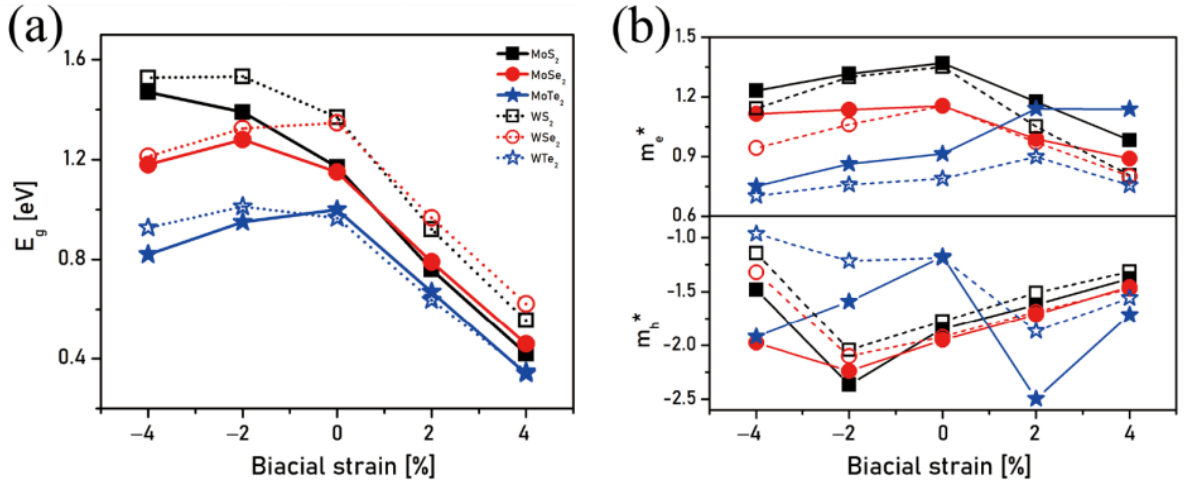
Figure 3. ( a ) Bandgap energies and ( b ) electron and hole effective masses (m e * and m h *, respectively) at the respective CBMs and VBMs with respect to applied strains from −4% to +4% for the MX 2 bilayer structures (M = Mo, W; X = S, Se, Te).